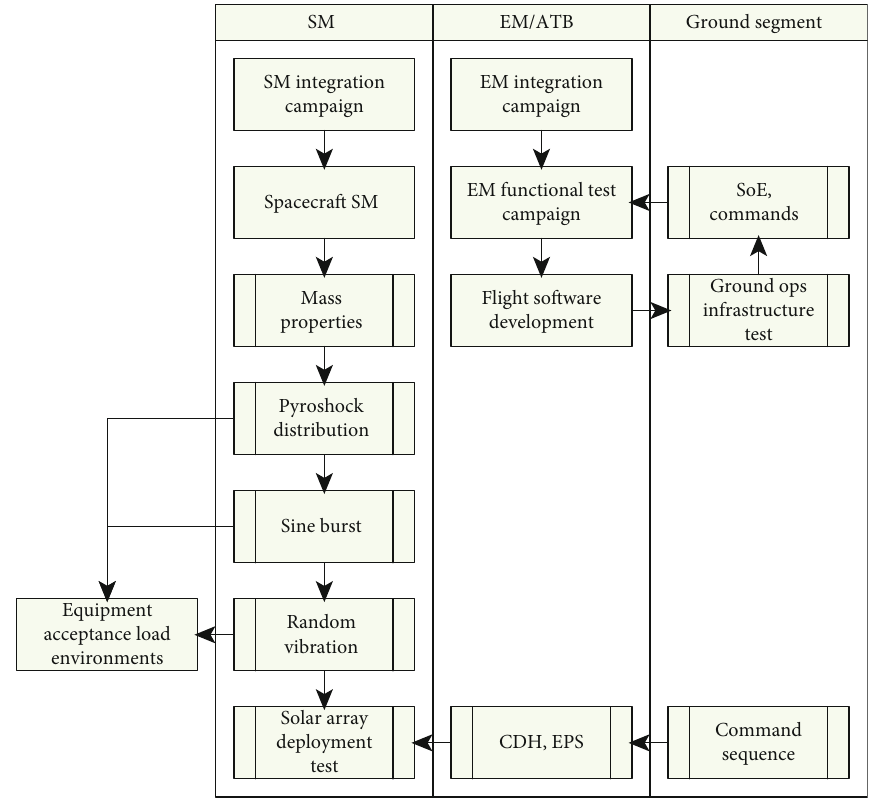
Figure 7: Eu:CROPIS quali fi cation